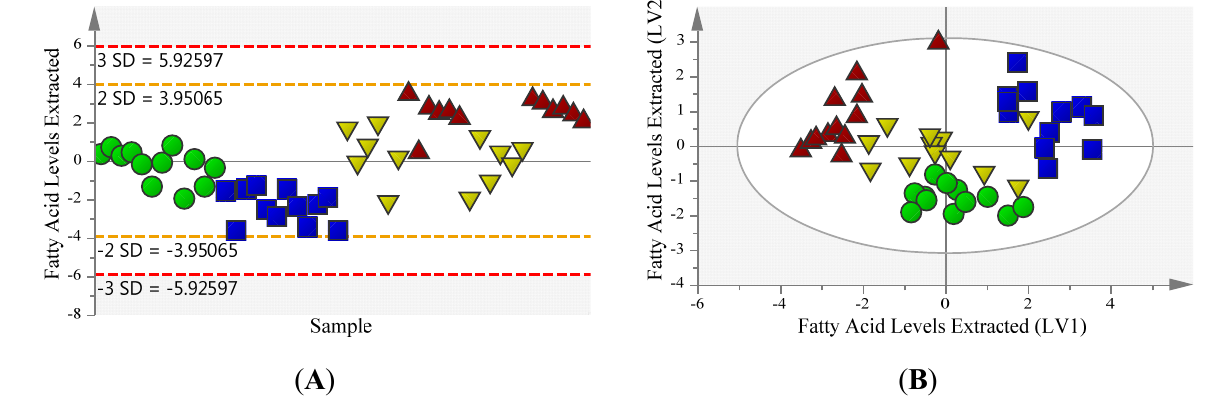
Figure 2. Models for fatty acid metabolites extracted from S. cerevisiae by one of three chloroform/methanol/water based extraction protocols. Fatty acid methyl esters (FAME’s) were identified through comparison to a 37 FAME standard. An overview of the data confirms that there are no outlying samples within a 95% confidence interval. Green circles represent samples extracted using method 1, blue squares represent samples extracted using method 2, red triangles represent apolar (17:1 CHCl :MeOH) organic fraction samples 3 extracted using method 3 and yellow upside down triangles represent polar (2:1 CHCl :MeOH) 3 organic fraction samples extracted using method 3. ( A ) PCA scores plot model with R 2 = 0.325 and Q 2 = 0.176 values. ( B ) OPLS-DA scores plot model showing separation based on extraction method with R 2 (X) = 0.616, R 2 (Y) = 0.517, Q 2 = 0.411 and CV-ANOVA p = 1.48 × 10 − 6